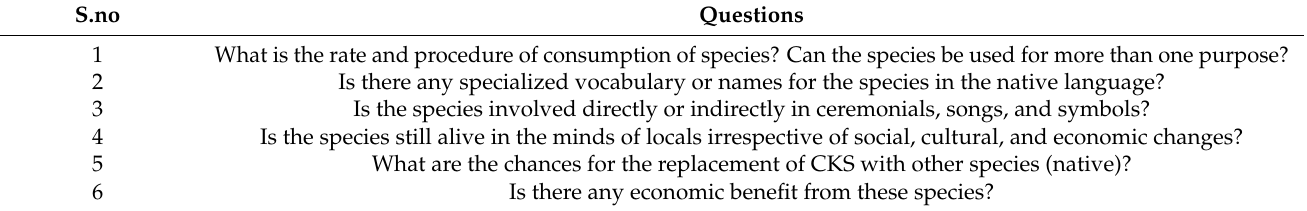
Table 1. Questions for reporting cultural keystone species following Rahmonov et al. [2] and Garibaldi and Turner